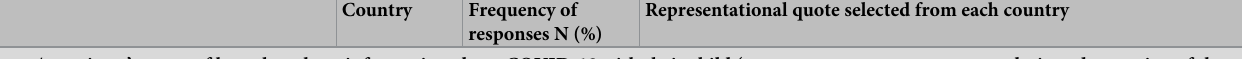
Table 6. Parents/caregivers’ decisions, choices and approaches to their child’s access to information about COVID-19. Country Frequency of Representational quote selected from each country responses N (%) Parent/caregivers’ report of how they share information about COVID-19 with their child (open text responses, content analysis and reporting of the most frequent responses) Shielding my child from